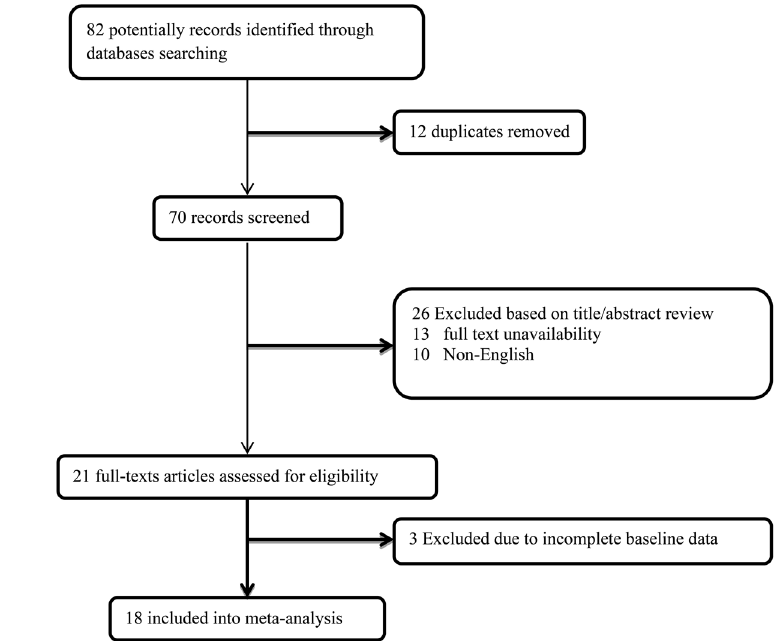
Figure 1. The flowchart of screening the eligible